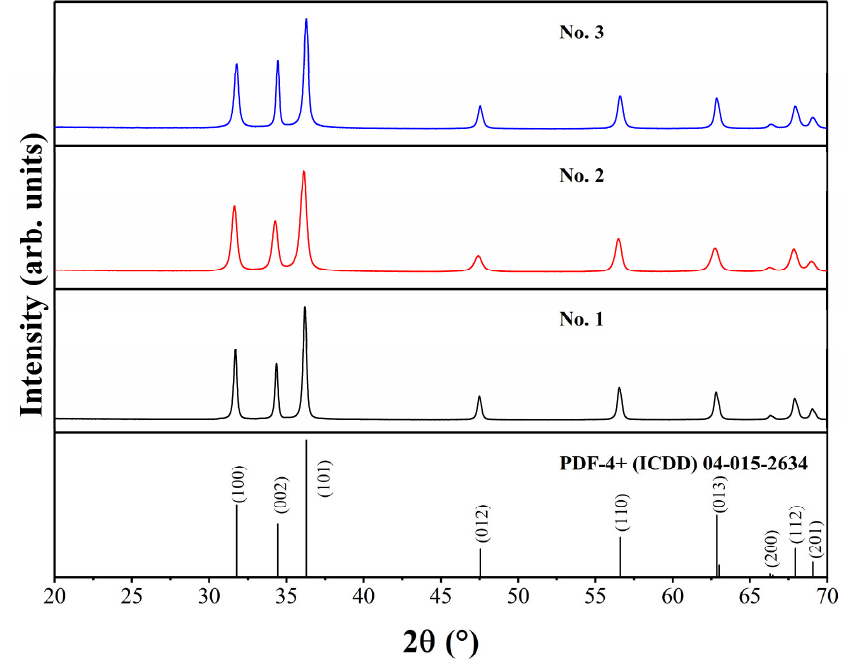
Figure 1. XRD patterns of ZnO samples.